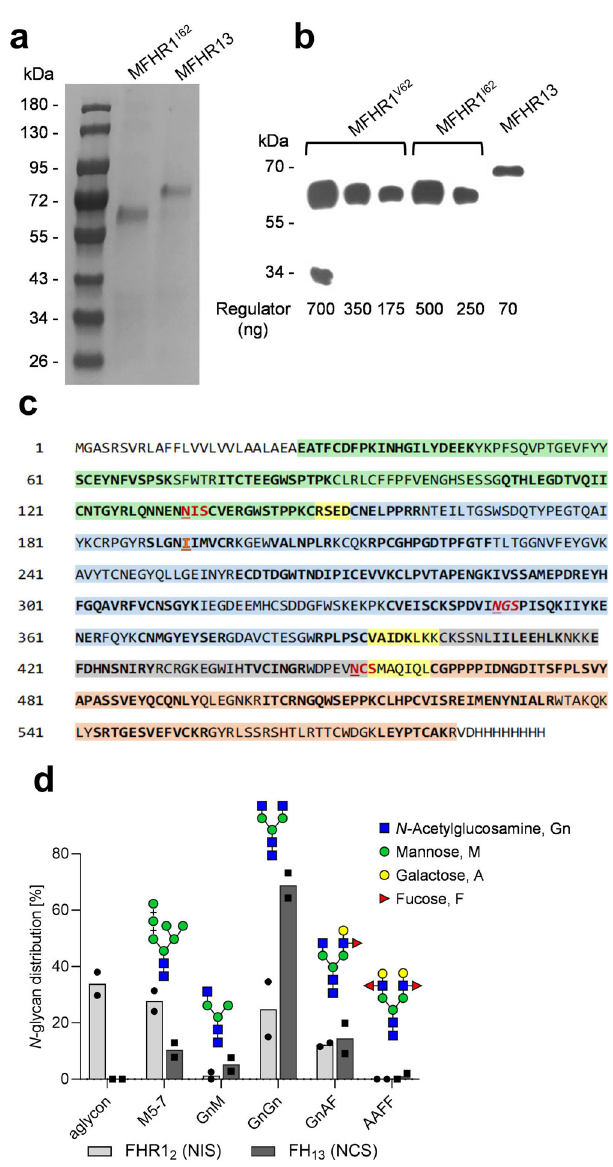
Fig. 4 MFHR13 structure and sequence characterization. a Coomassie staining of puri fi ed MFHR1 I62 and MFHR13 via Ni-af fi nity and anion exchange chromatography. Samples were separated on SDS-PAGE under reducing conditions. b Semi-quantitative western blot of MFHR1 V62 , MFHR1 I62 , and MFHR13 under reducing conditions and detected with anti-His-tag antibodies. A calibration curve was obtained with MFHR1 V62 and densities of the western blot signal were compared with the concentrations obtained by ELISA (included under each lane). One representative experiment is shown.